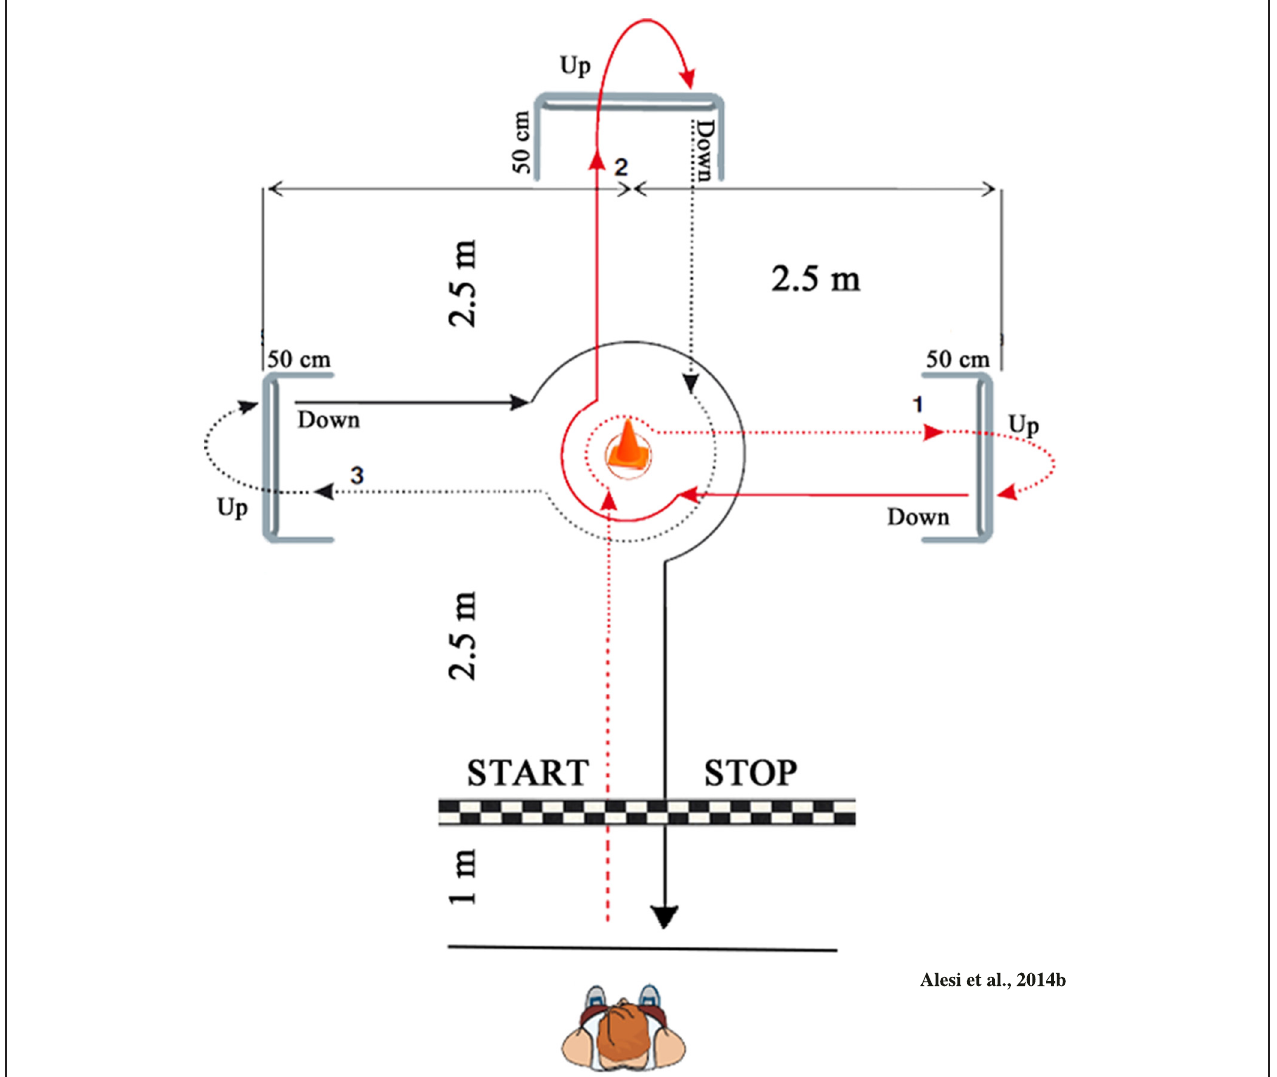
FIGURE 1 | Agility test.